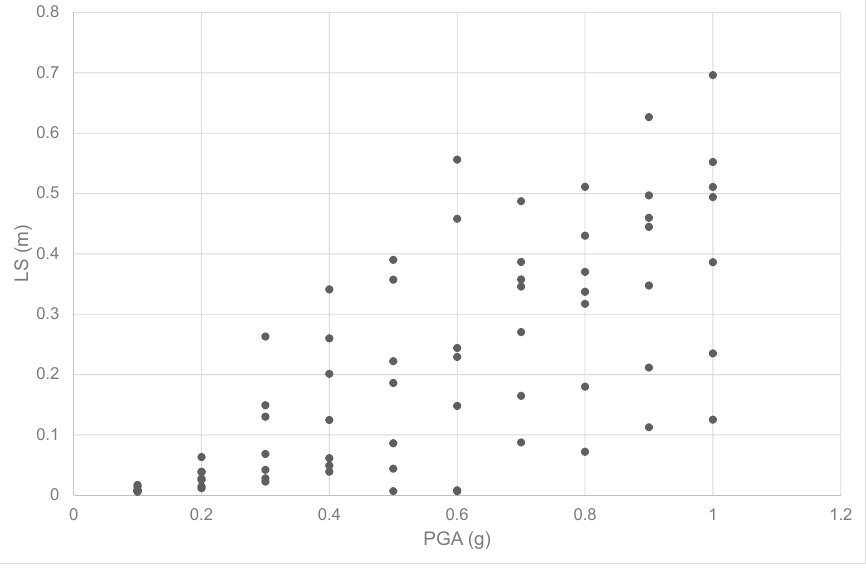
Figure 7. FF: relationships between PGA (g) and LS (m).